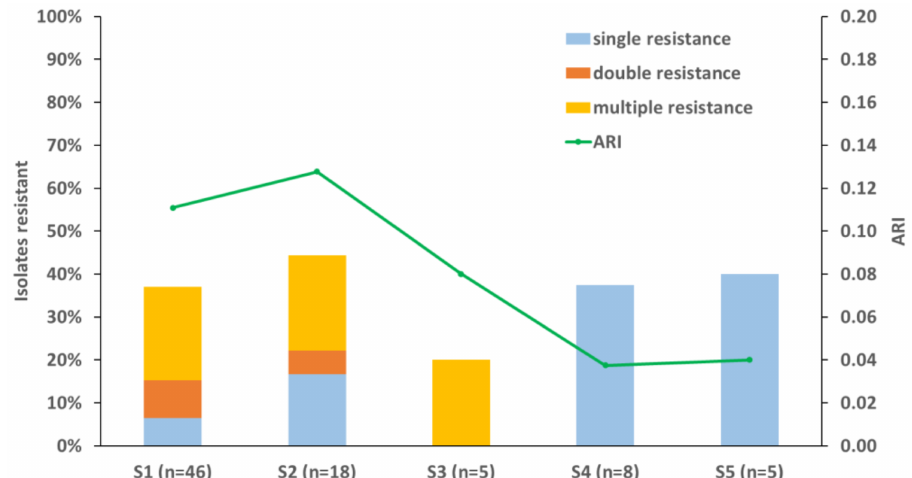
Figure 2. Distribution of resistant E. coli and antibiotic resistance index (ARI) across sampling sites in Fujiazhuang bathing beach. Single resistance: resistance to one antibiotic; Double resistance: resistance to two antibiotics; Multiple resistance: resistance to three or more antibiotics.